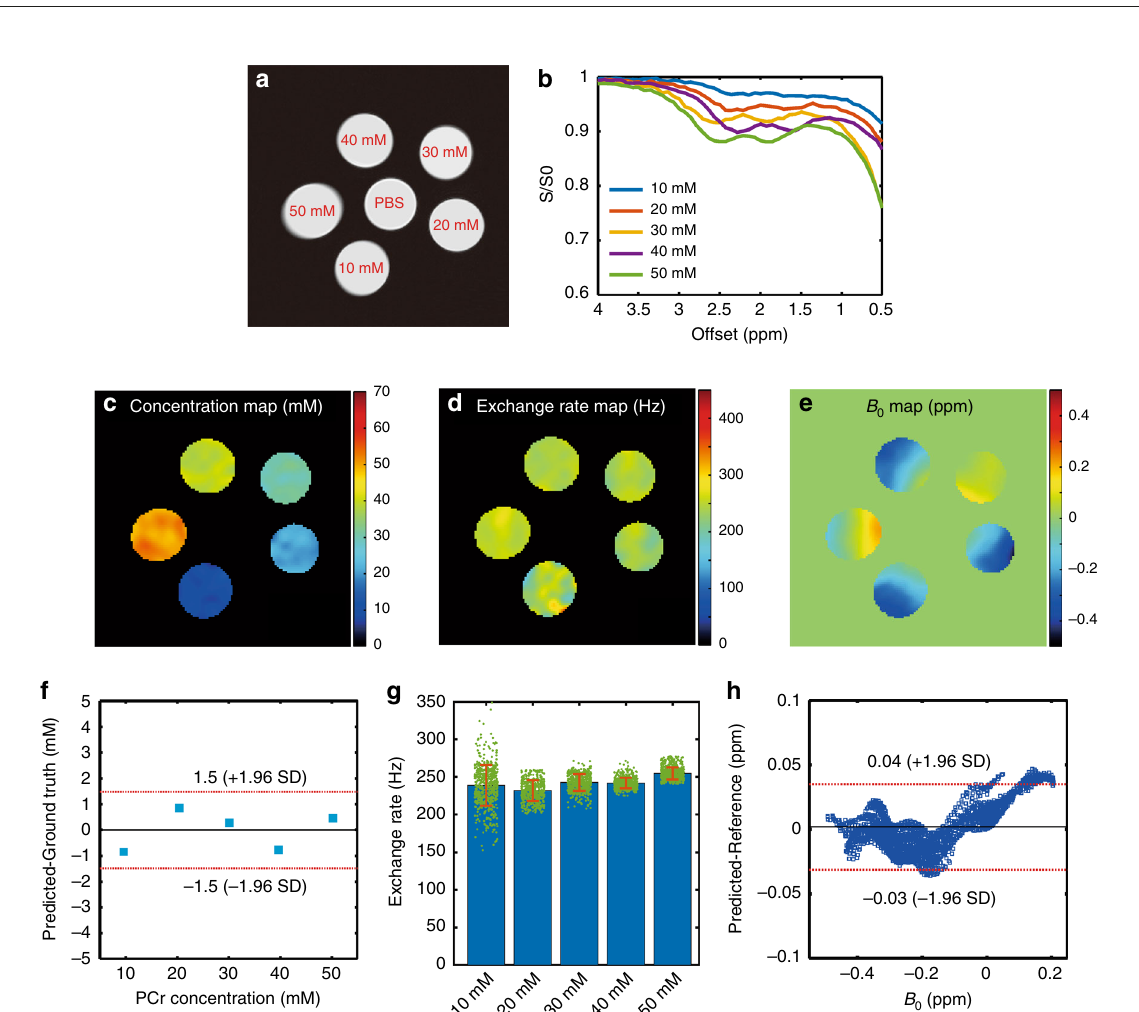
Fig. 1 Validation of ANNCEST with numerical simulation. a Diagrammatic representation of the feed-forward arti fi cial neural network used in this study. This network comprises three layers: an input layer, fully connected hidden layers, and an output layer. The input of the neural network is the intensity of the Z spectrum at different frequency offsets, and the outputs are the predicted values of metabolite concentrations, exchange rates of exchangeable protons, and B 1 / B 0 . b Representative Z spectra of PCr phantom generated by three-pool Bloch – McConnell equations. Z spectra from 0.5 to 4.0 ppm were sampled with a 50-saturation offset over equal intervals. Gaussian white noise with a standard deviation of 0.35% and B 0 inhomogeneity offsets were added to the Z spectra. The saturation power and length were set to 0.6 µ T and 10 s, respectively. c The performance of neural networks as a function of the number of hidden layers. The error bar was obtained by repeating the neural network training fi ve times. d – f The ground truth maps of concentration, exchange rate at 2.5 ppm, and B 0 for generating validated Z spectra. The matrix size of maps is 256 × 256. The maps of concentration, exchange rate, and B fi tting ( g , h ) and ANNCEST ( j – l ), respectively. m , n Quanti fi ed concentrations and exchange rates, respectively. The bar and 0 obtained by Bloch equation error bar indicate the mean value and standard deviation across each phantom, respectively ( n = 4523, 3655, 2770, 2610, and 2790 pixels for phantom numbers 1 – 5, respectively).